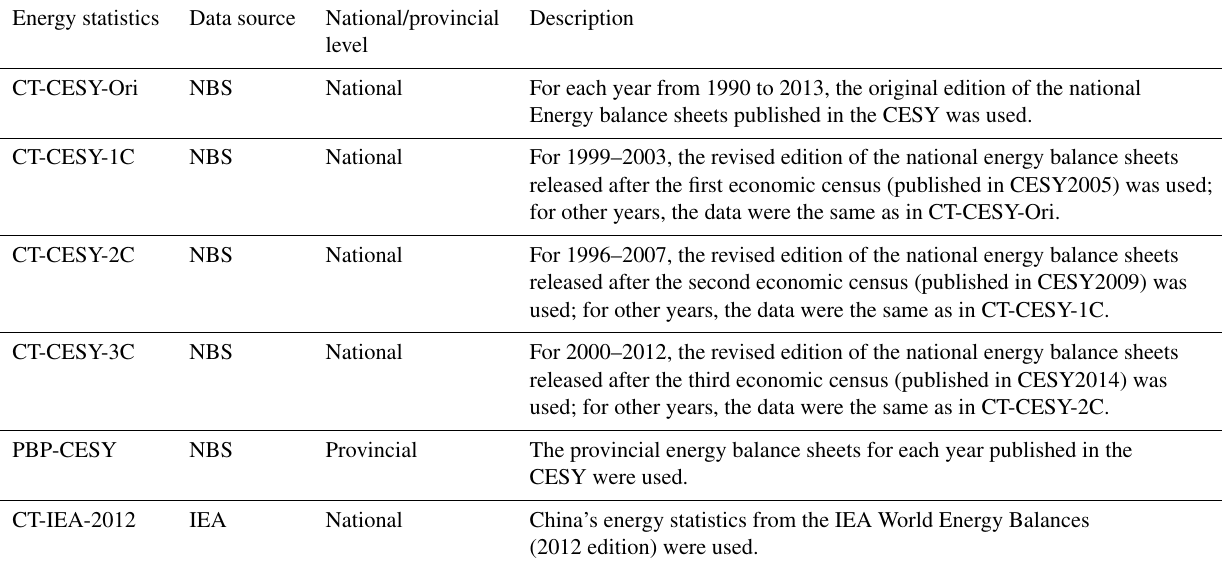
Table 1. The energy statistics for China involved in this work. Energy statistics Data source National/provincial Description